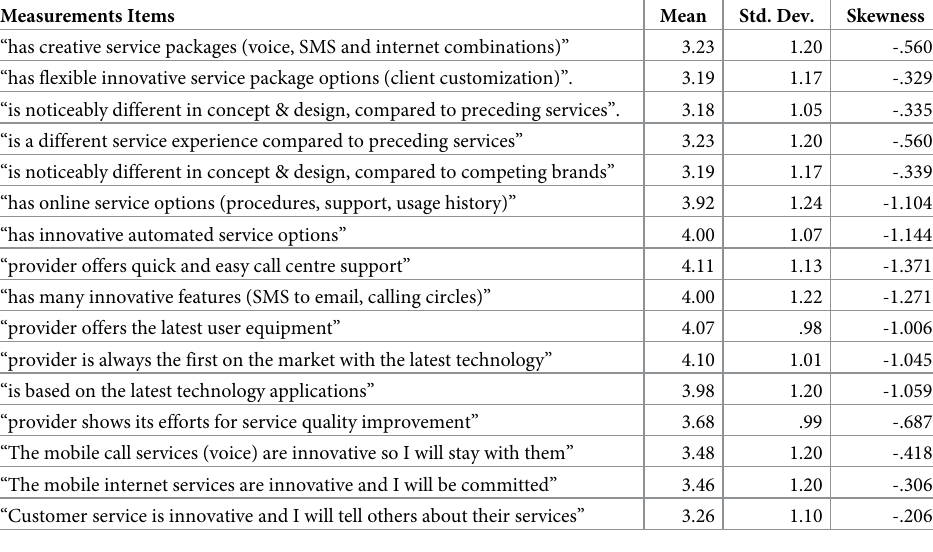
Table 3. Descriptive statistics of measurement. Measurements Items